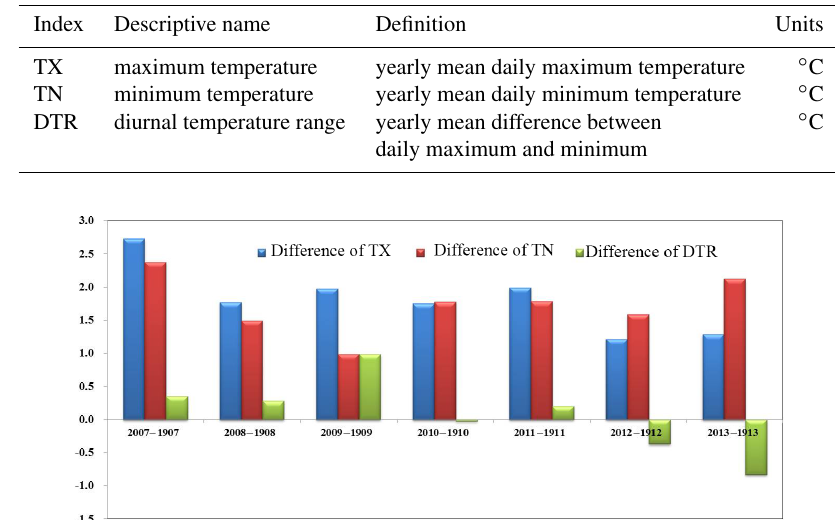
Table 4. Definitions of temperature indices used in this study.